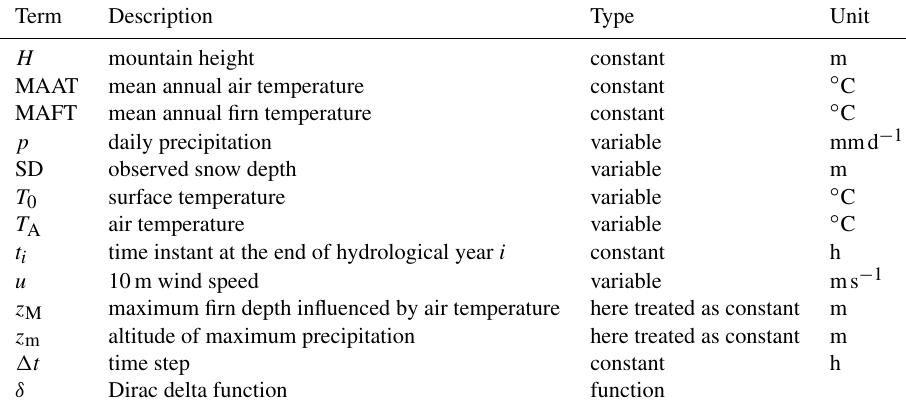
Table B7. List of other symbols and abbreviations used throughout the paper. Term Description Type Unit H mountain height constant m MAAT mean annual air temperature constant ◦ C MAFT mean annual firn temperature constant ◦ C p daily precipitation variable mmd − 1 SD observed snow depth variable m T 0 surface temperature variable ◦ C T A air temperature variable ◦ C t i time instant at the end of hydrological year i constant h u 10m wind speed variable ms − 1 z M maximum firn depth influenced by air temperature here treated as constant m z m altitude of maximum precipitation here treated as constant m (cid:49)t time step constant h δ Dirac delta function